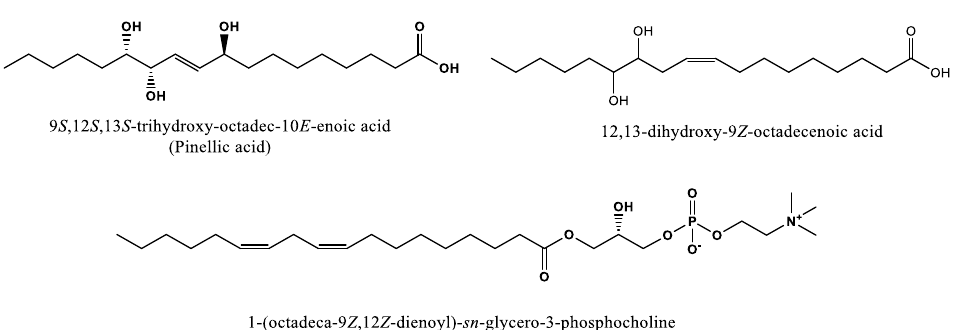
Figure 4. Chemical structures of three highly predictive compounds of whole wheat bread flavor disliking made with aged flour.